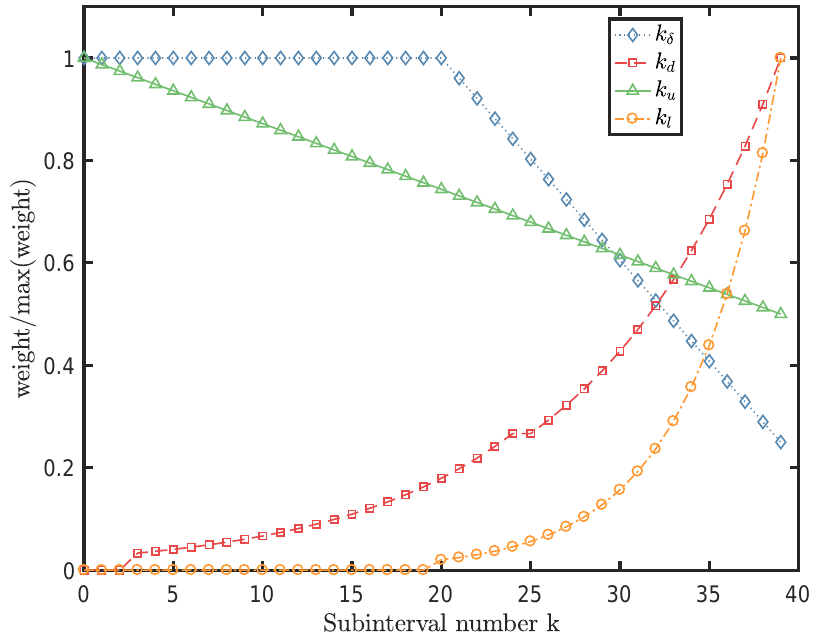
Figure 8. An example of the normalizing weights for Region III with respect to the subinterval